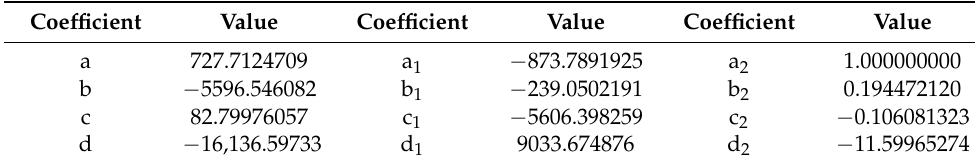
Table 3. Values resulting from the coefficients (second